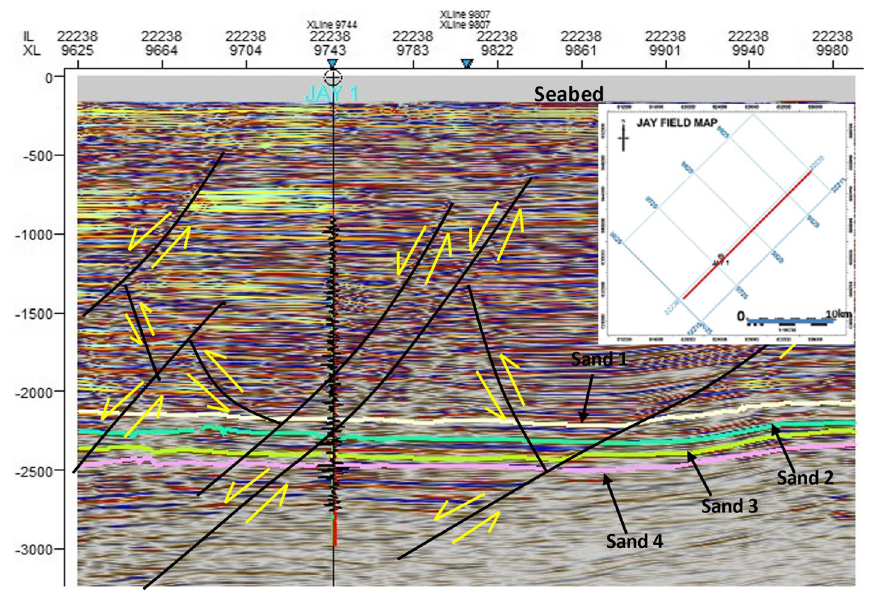
Fig. 12 Seismic interpretation of fault and hydrocarbon horizons in Jay